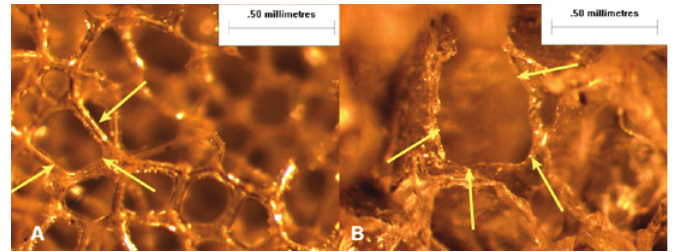
FIGURE 2 – Photomicrographs of the foams. A . Implant of polyurethane. B . Implant of silicone (57x).